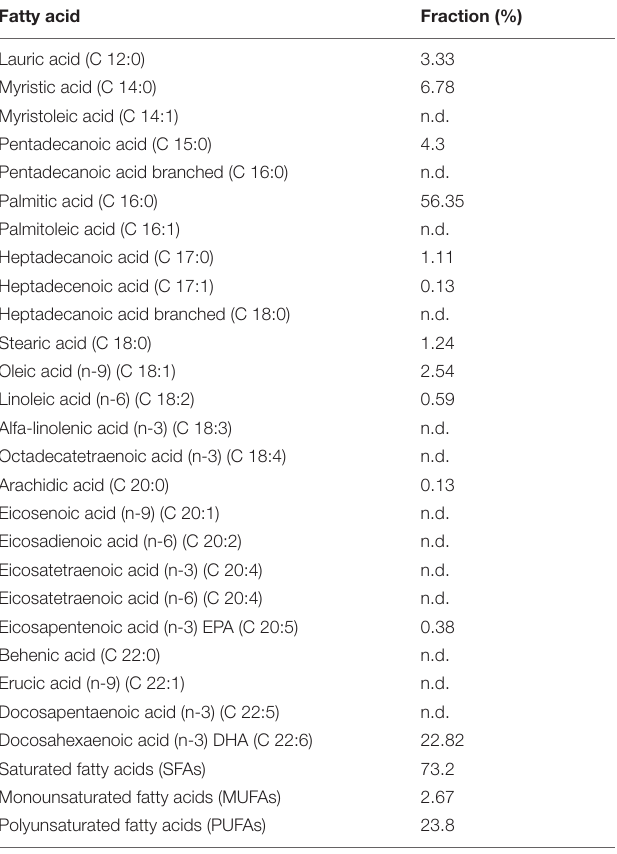
TABLE 5 | Fatty acids profile of S. limacinum